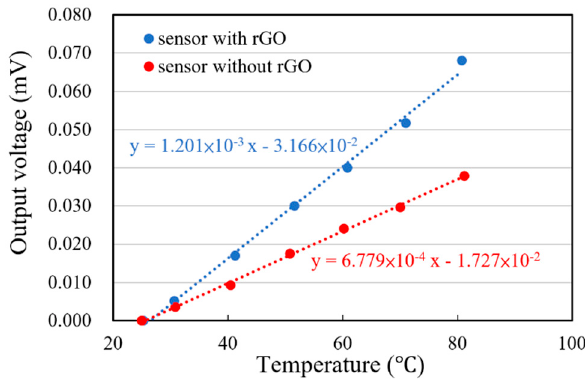
Figure 8. Output voltage of the sensors vs. target temperature from the black body.